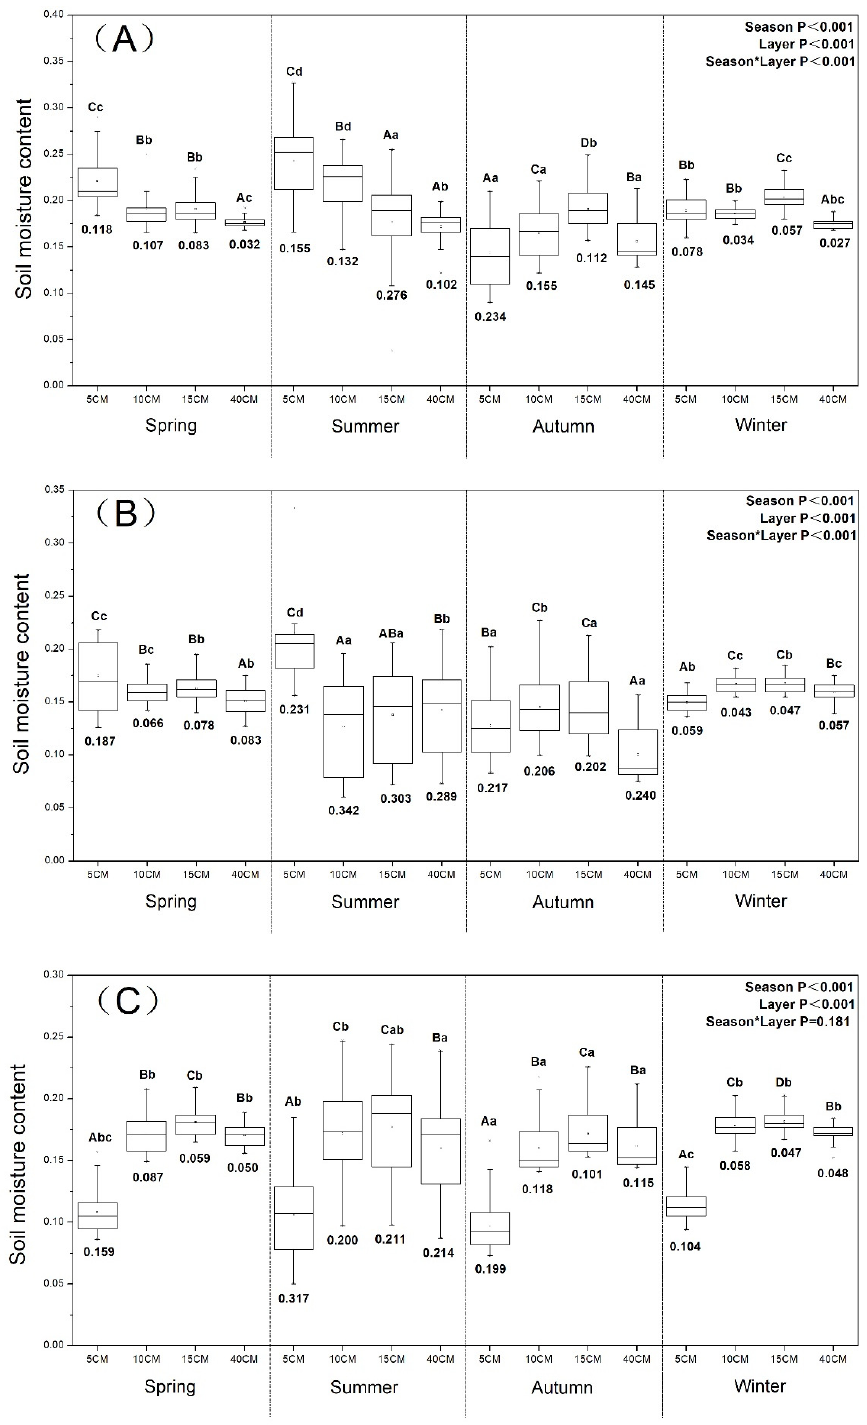
Figure 3. Box diagram of moisture content of each soil layer across four seasons (Note: Empty circles within each box represent the average soil moisture content value; middle lines within each box represent the median soil moisture content value; vertical lines represent the interquartile ranges; upper case letters indicate significant differences between different soil layers during the same season ( p < 0.05); lower case letters indicate significant differences between different seasons of the same soil layer ( p < 0.05); values below box charts are the coefficients of variation; ( A ): grassland; ( B ): Q. acutissima ; ( C ): C. lanceolata ; land types: p < 0.001).